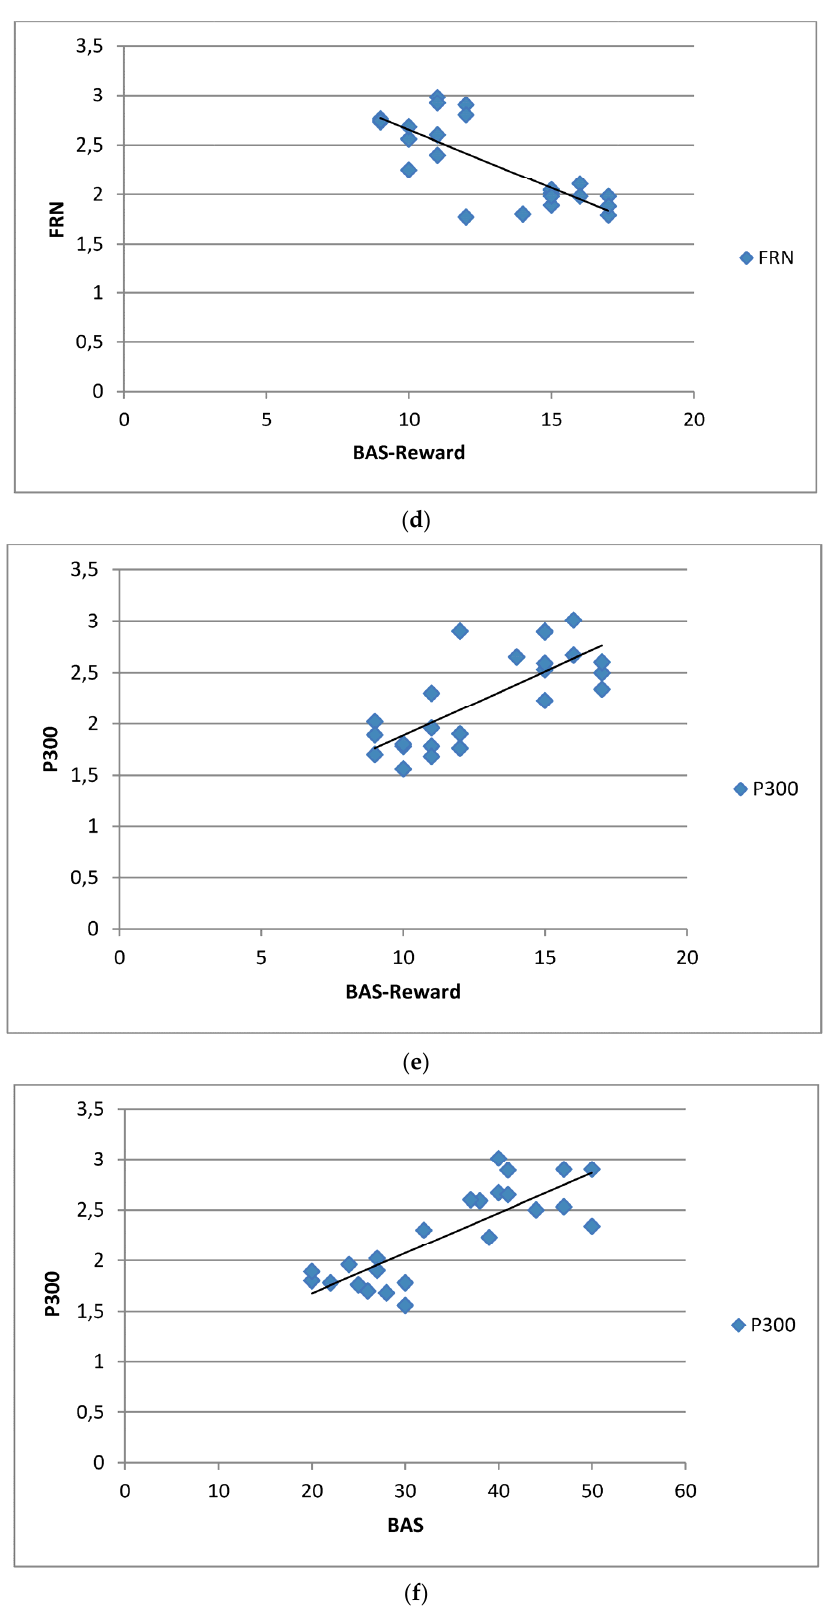
Figure 4. ( a – f ) Scatterplots of IAT, FRN/P300 and BAS (and BAS-Reward) Pearson correlations.